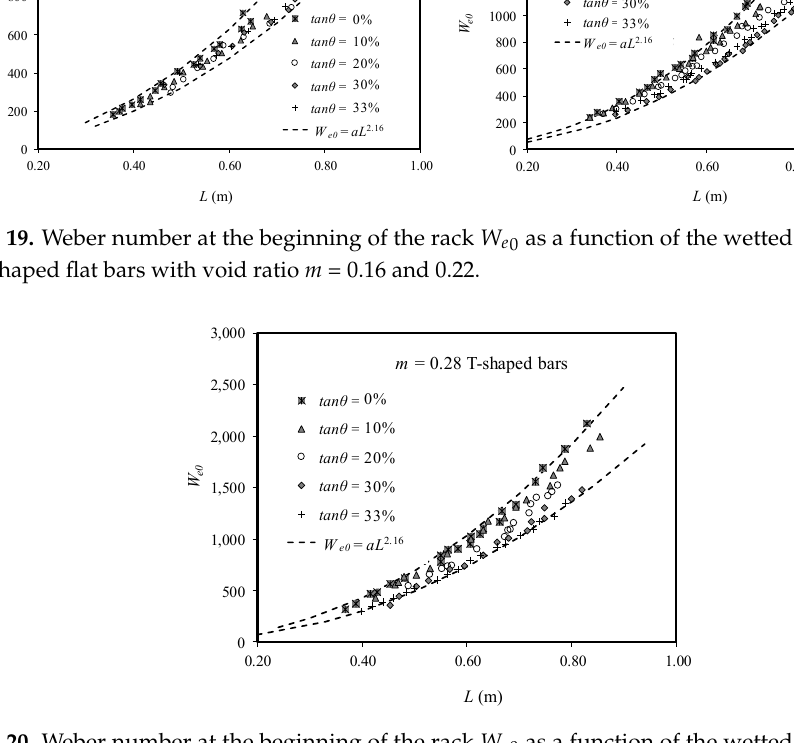
Figure 20. Weber number at the beginning of the rack W e 0 as a function of the wetted rack length L , for T-shaped flat bars with void ratio m = 0.28.